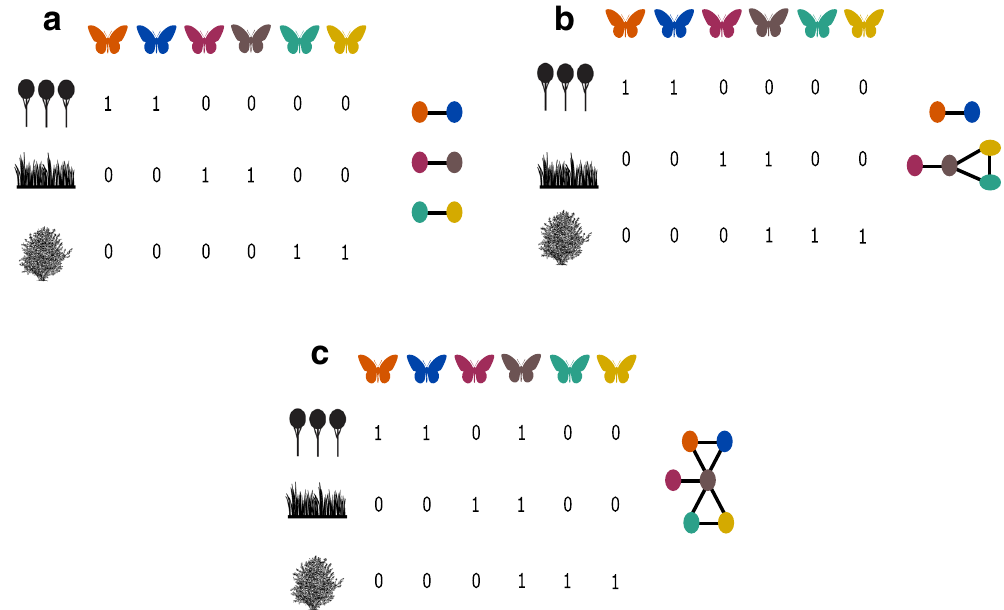
Figure 3. We use co-occurrence matrices (and their network representations) to explore the influence of habitat generalist species in the evolution of mimicry rings. In these matrices each column represents a distinct aposematic species and each line represent a distinct habitat. (a) Perfectly modular scenario —where each species only occurs in only one habitat. ( b ) In this scenario the brown species occurs in more than one habitat, connecting species purple with species green and yellow. ( c ) In this scenario brown species is a supergeneralist— occurring in all habitats and connecting all